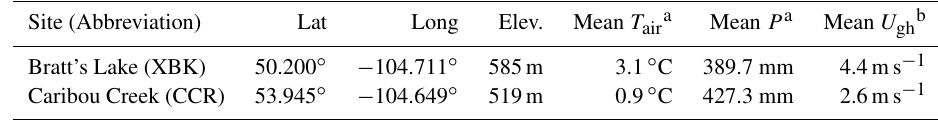
Table 1. Saskatchewan SPICE site locations (latitude, longitude, and elevation), mean annual air temperature ( T air ), mean annual total precipitation ( P ), and mean wind speed at gauge height ( U gh ).